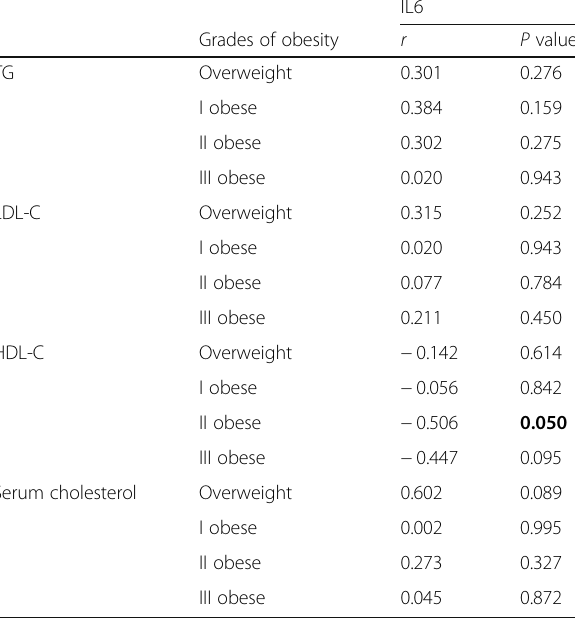
Grades of obesity (No, %)